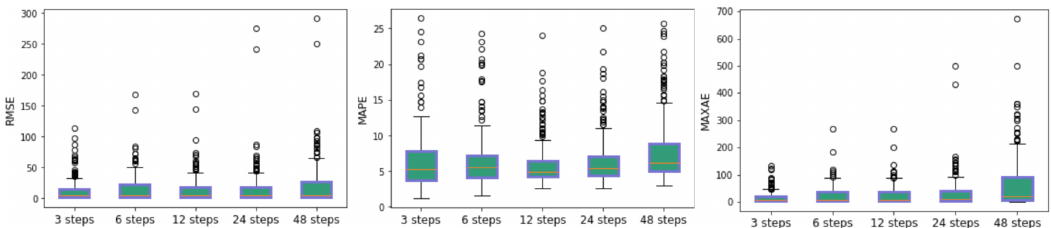
Figure 17. The graphics shows how is each type of error (RMSE, MAPE and MAXAE) distributed for the CNN-LSTM hybrid model in five different multi-step cases : 3, 6, 12, 24 and 48